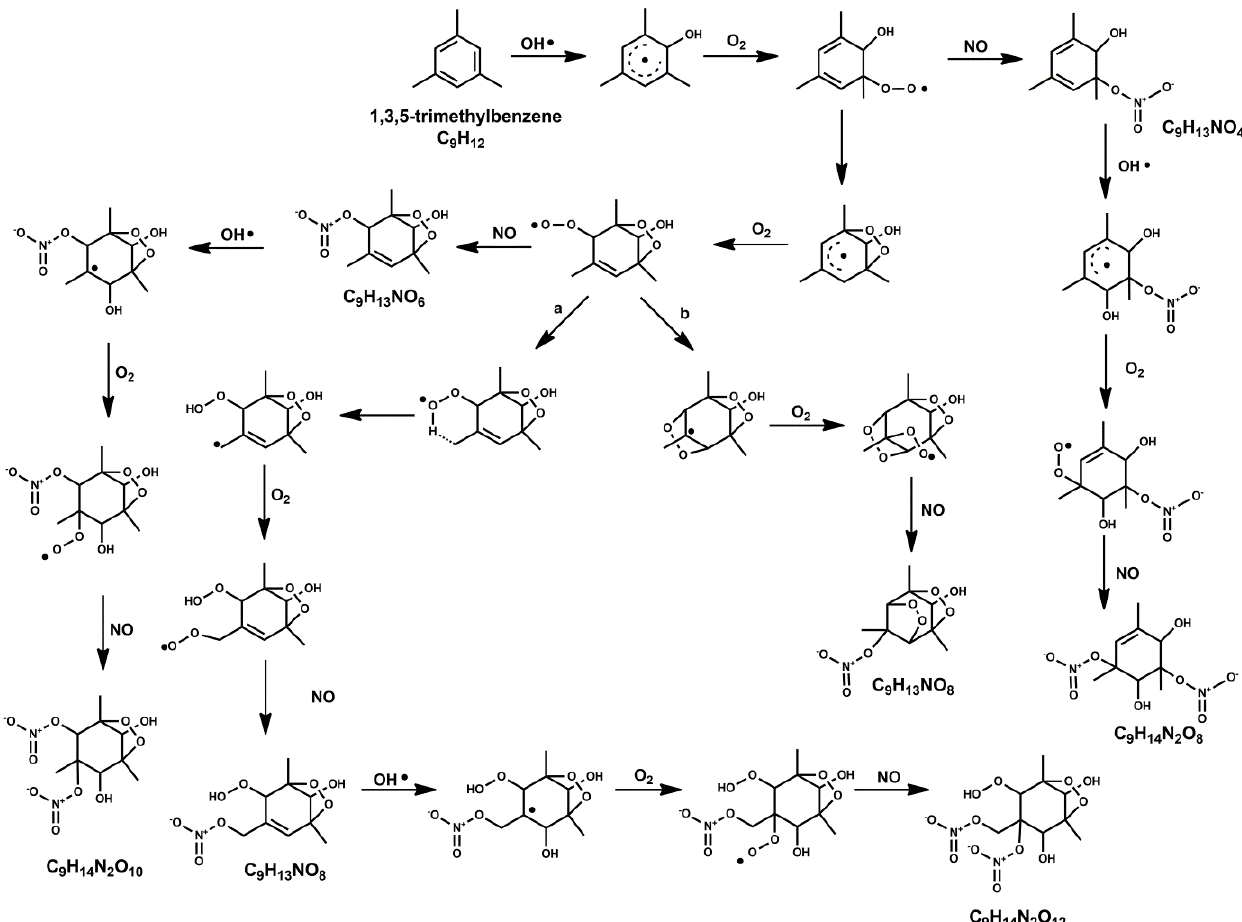
Figure 5. The proposed radical reaction mechanism for the formation of some of the mono- and di-nitrates from TMB mentioned in this study. Two separate mechanisms were suggested for the species with the formula C 9 H 13 NO 8 , and formation pathways are based on (a) Wang et al. (2017) and (b) Molteni et al.